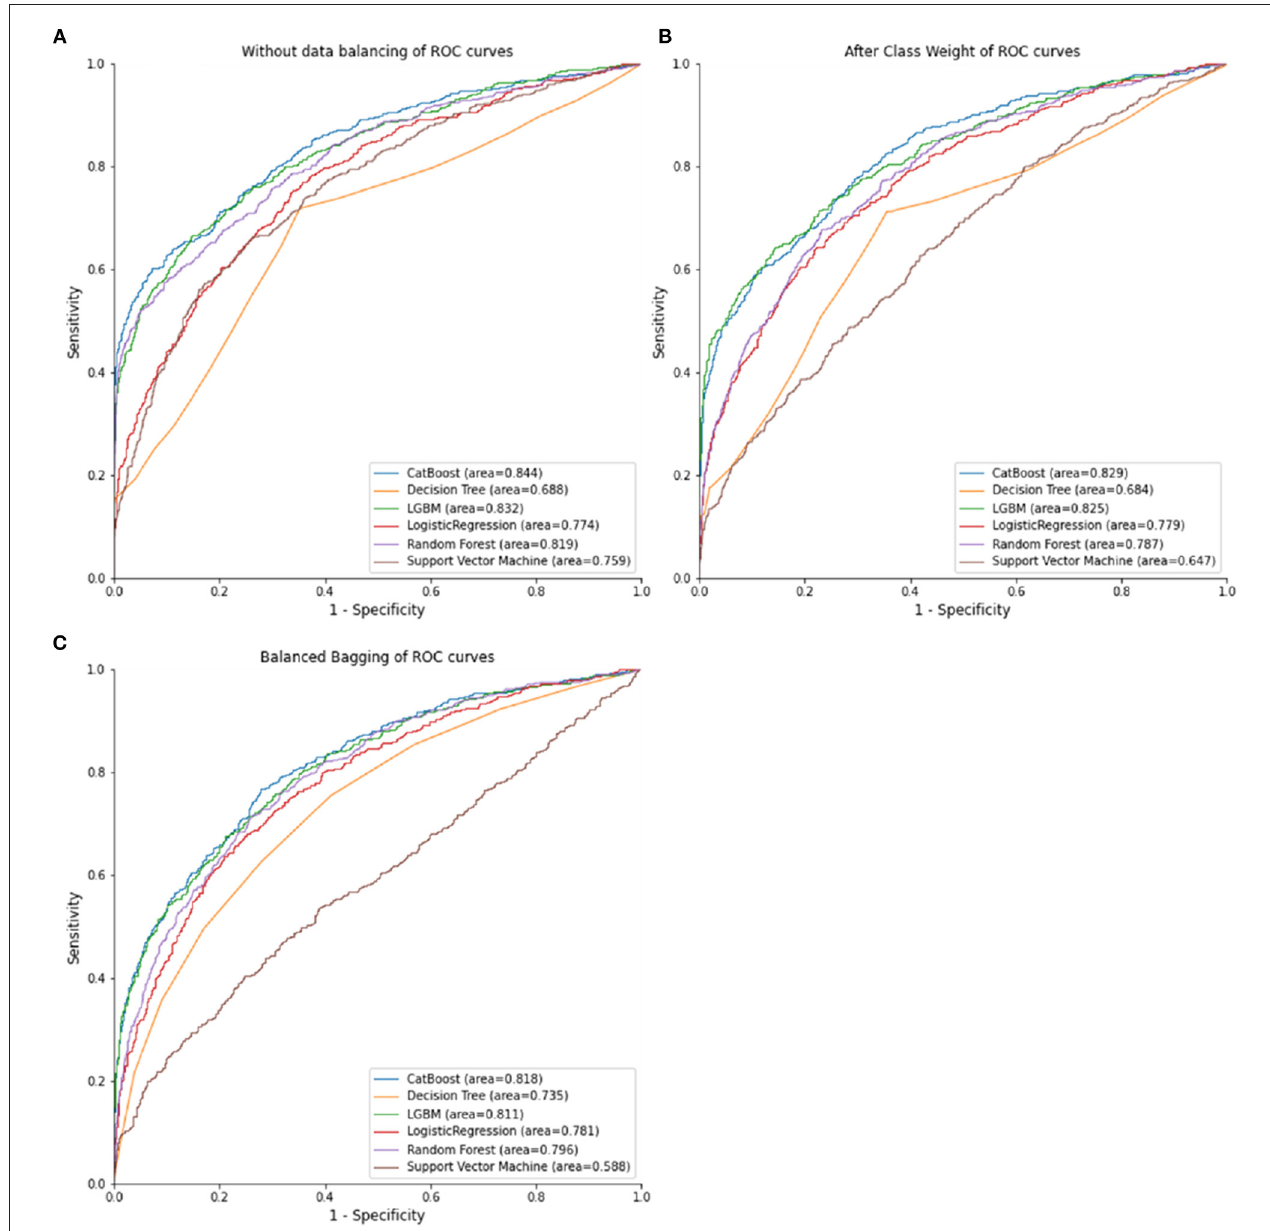
FIGURE 2 | ROC curves of combinations of different data balancing methods and machine learning algorithms. (A) No data balancing. (B) After class weight. (C) balanced bagging.